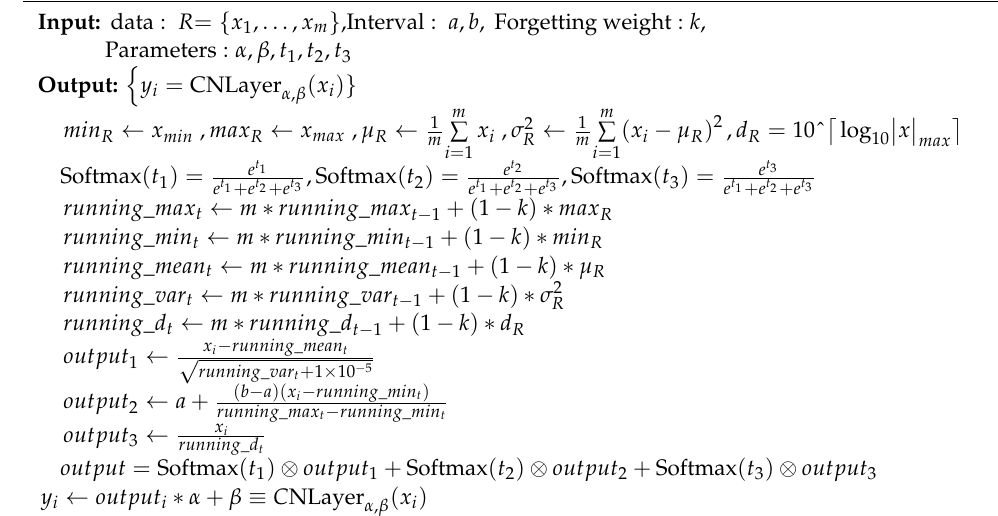
Algorithm 1: Pseudocode for combinatorial normalization